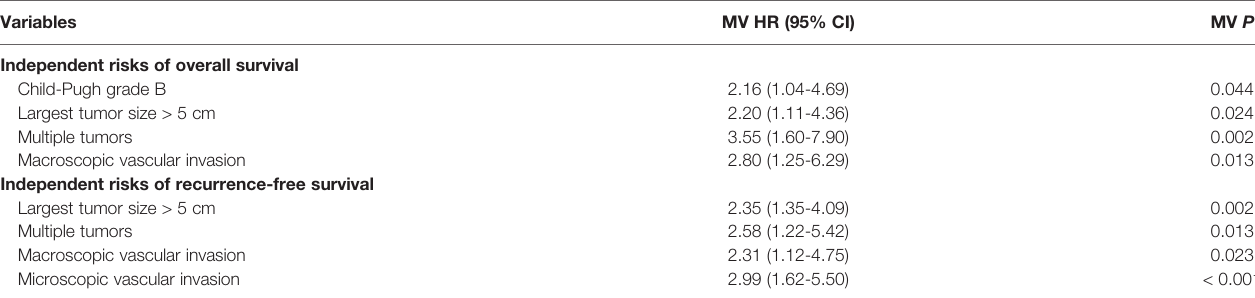
TABLE 3 | Independent prognostic factors associated with overall survival and recurrence-free survival after liver resection for hepatocellular carcinoma among patients with HBV/HCV co-infection by multivariable Cox-regression analysis. Variables MV HR (95% CI) Independent risks of overall survival Child-Pugh grade